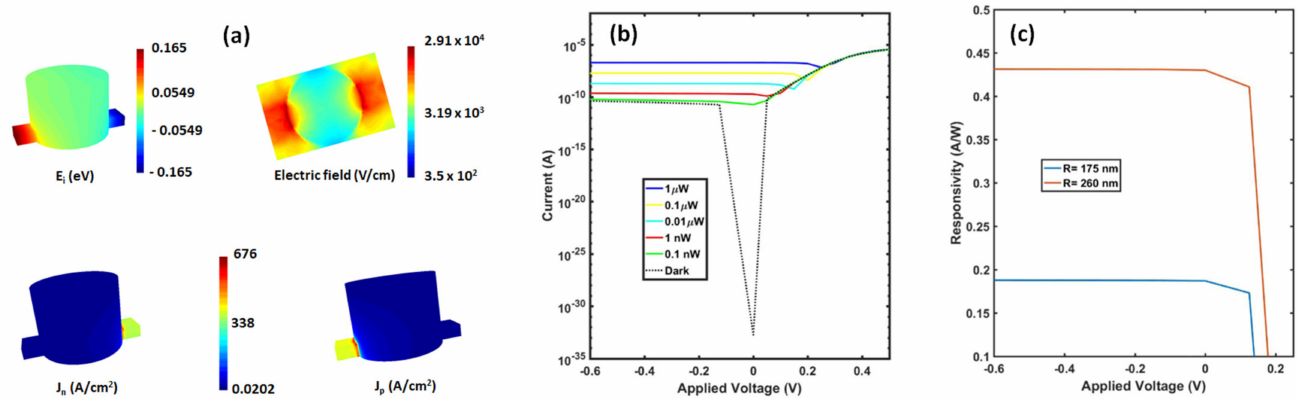
Figure 5. Electrical response of the photodetector. Panel ( a ) shows intrinsic energy level E i , electric field magnitude at xy- plane, and electron (hole) current density Jn (Jp) at zero bias for the device of R = 175 nm ( H = 275 nm). ( b ) Current-voltage characteristics for the device of R = 175 nm ( H = 275 nm) at dark and at various illumination. ( c ) responsivity of the device of R = 175 nm ( H = 275 nm) and of R = 260 nm ( H = 205